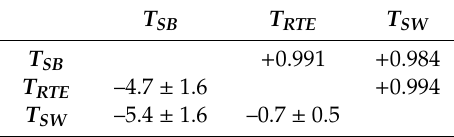
Table 4. Statistical relation among temperature maps obtained by di ff erent methods from a single Landsat-8 image (3 July). The upper triangle of the represented table shows the correlation coe ffi cients between map pairs; the lower triangle presents average and standard deviation of pair di ff erence (column-row, ◦